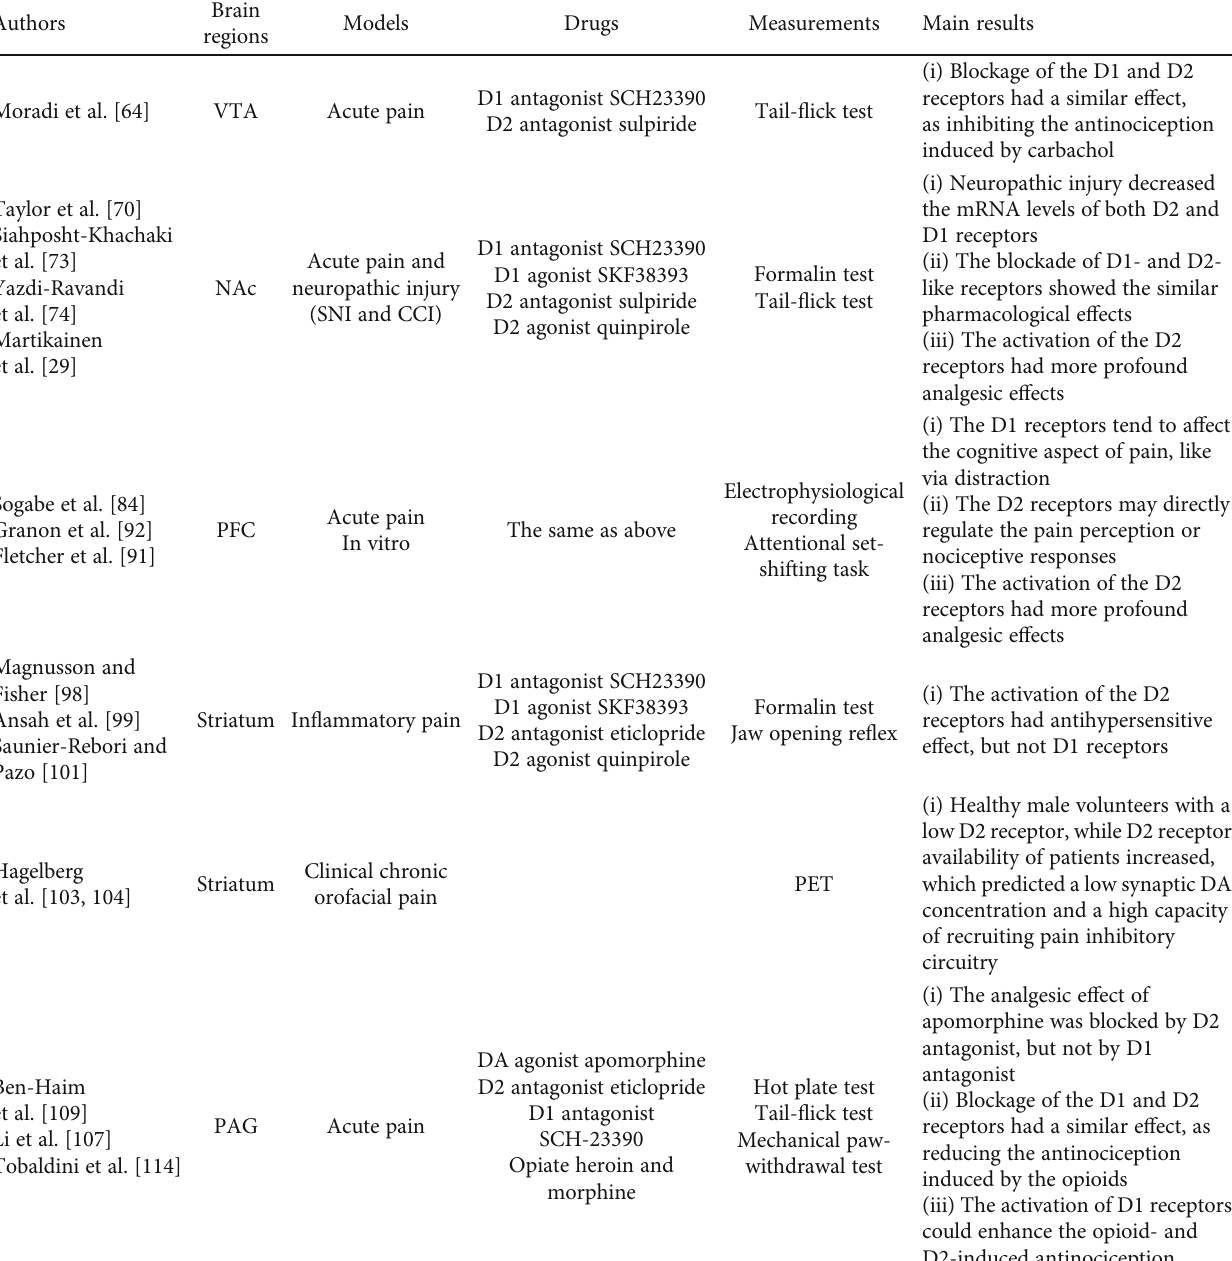
Table 2: The role of DA receptors on pain modulation in the